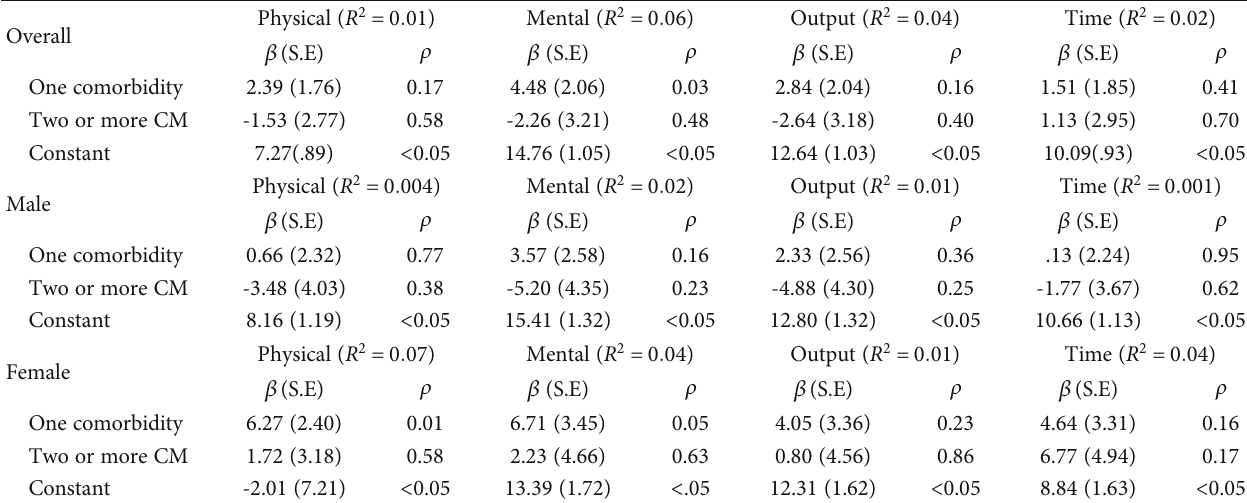
Table 6: Univariate regression results for the work limitation sub-scales among fi re fi ghters.